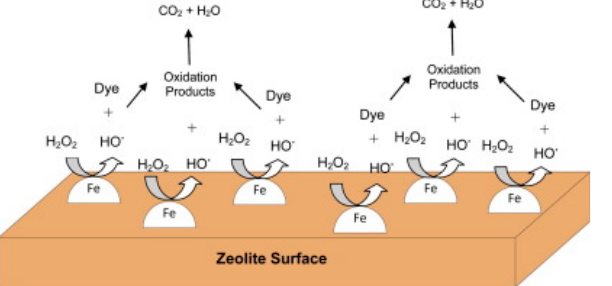
Figure 2. Formation of radicals on Fe-zeolite during oxidation of textile dyes. Reproduced with per- mission from Queirós et al., heterogeneous Fenton reaction oxidation using Fe/ZSM-5 as catalyst in a continuous stirred tank reactor, published by Separation and Purification Technology , 2015 [25].